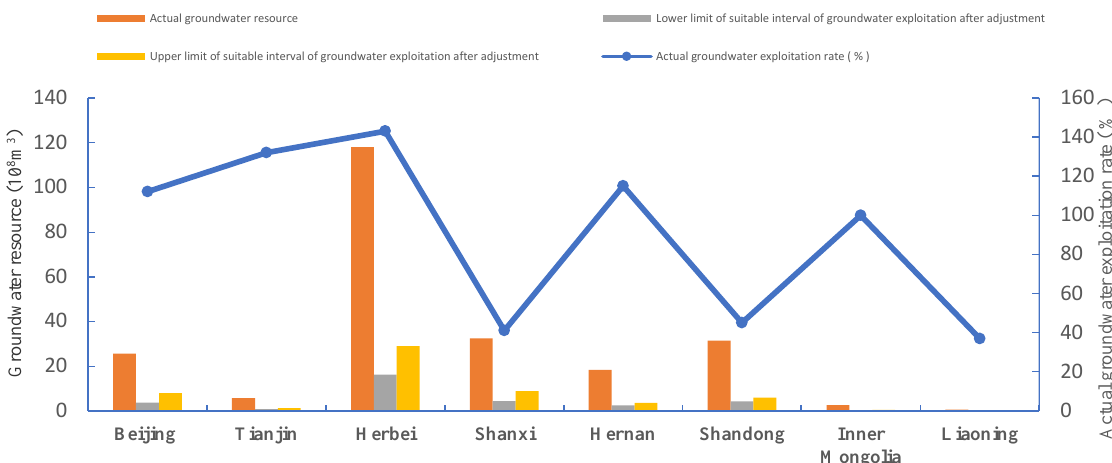
Figure 6. Actual groundwater resource, exploitation rate, and suitable groundwater exploitation after adjustment.